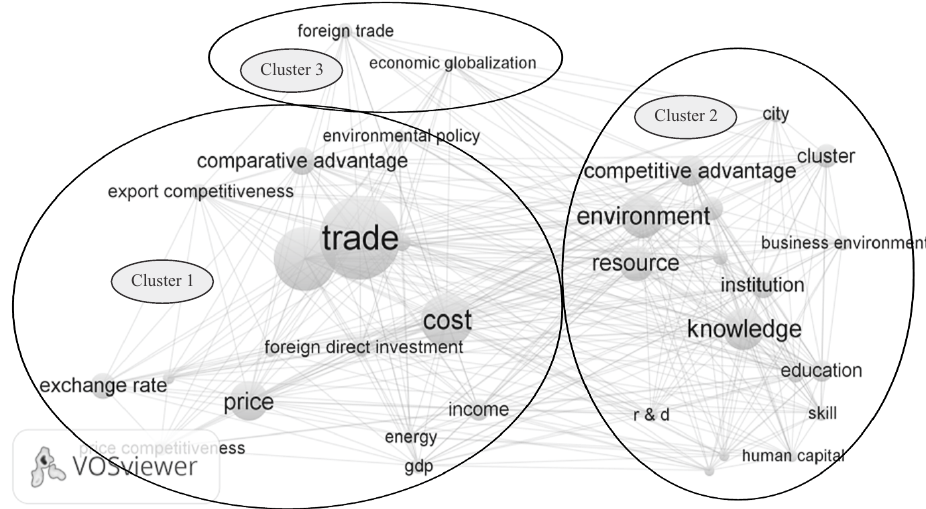
Fig. 5. Four clusters in the international competitiveness literature (2004–2015) by term co-occurrence analysis Source: Own calculation using Vosviewer software.